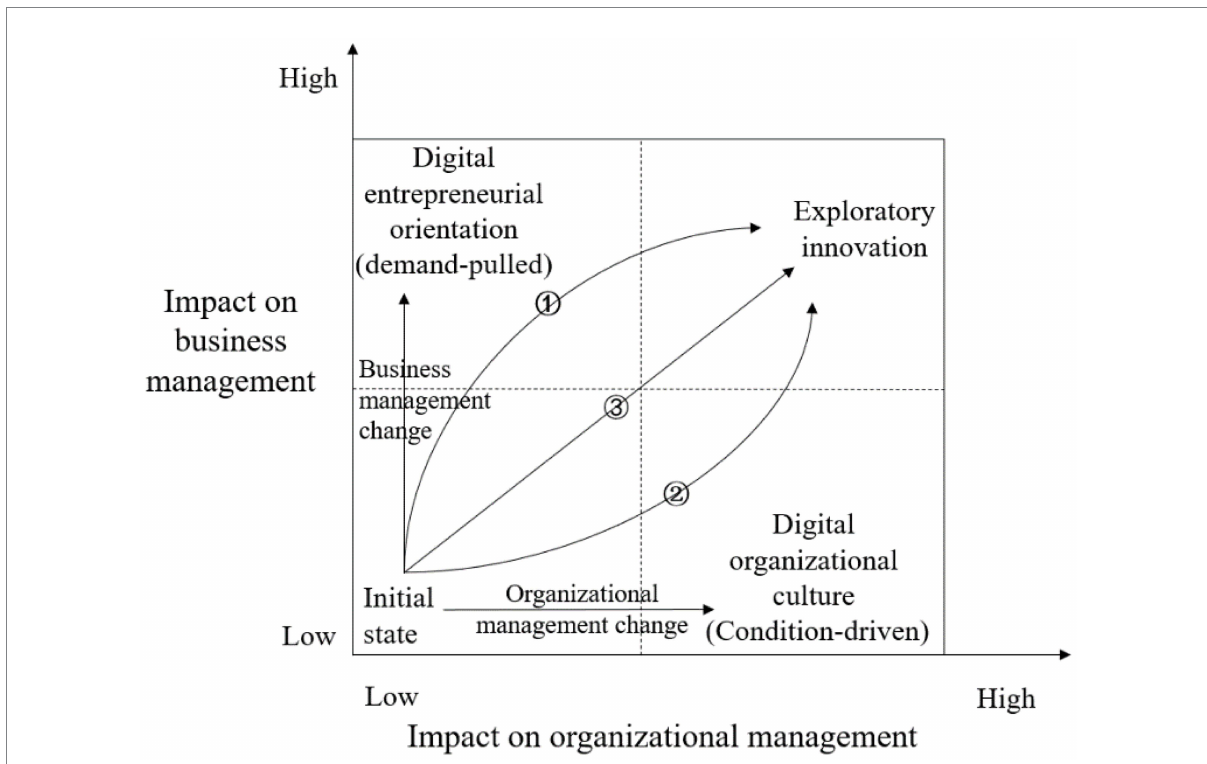
FIGURE 2 Path diagram of the impact of digital leadership to exploratory innovation. Note: ① business management route; ② organizational management route; ③ equal emphasis on management and